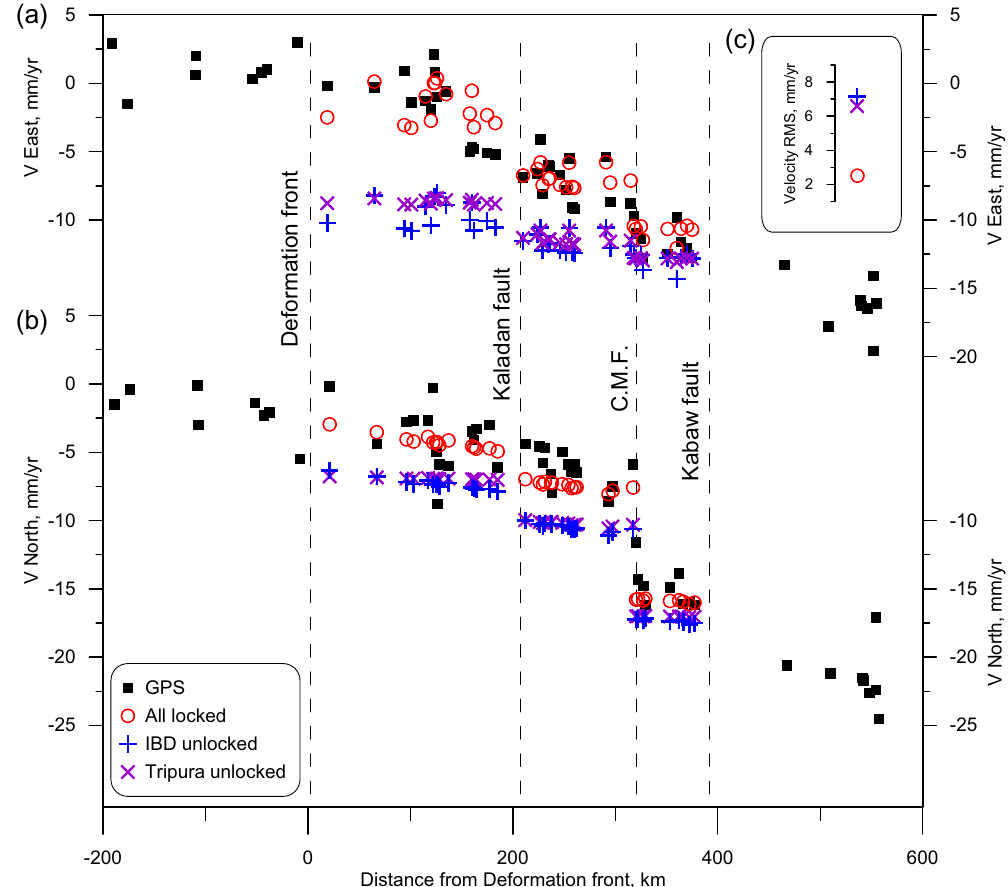
Figure 3. Changes of the modeled interseismic velocities across the Indo-Burman arc as simulated in three experiments. The values are given at the GPS sites, their locations in the plot are distances to the nearest fault. Fault locations (dashed lines) are as at 24°N. The modeled velocities are shown by colored symbols; observed GPS velocities (Table S1) are shown by black squares. ( a ) Eastward velocities; ( b ) Northward velocities; ( c ) Residual Mean Squared velocity obtained in the three experiments, symbols are the same as in ( a ) and ( b